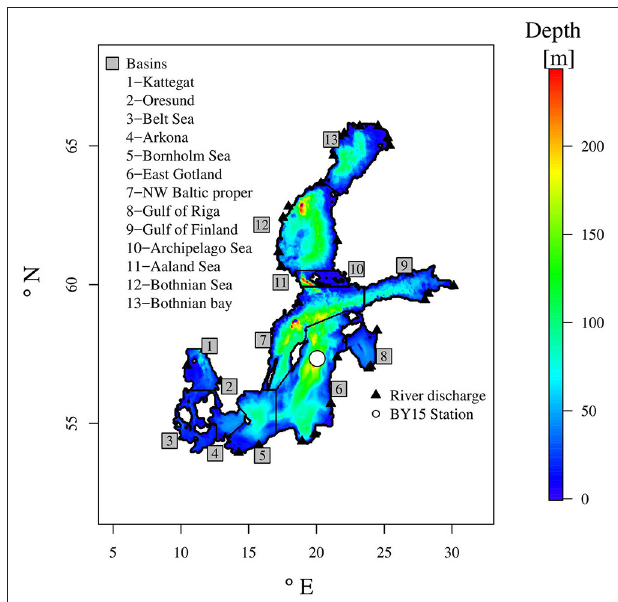
FIGURE 1 | The Baltic Sea: bathymetry, river discharges, and sub-basins as defined in this study. The Baltic proper comprises Arkona, Bornholm, East Gotland and Northwest Gotland basins. In addition, the location of the monitoring station at Gotland Deep (BY15) is shown (white circle).